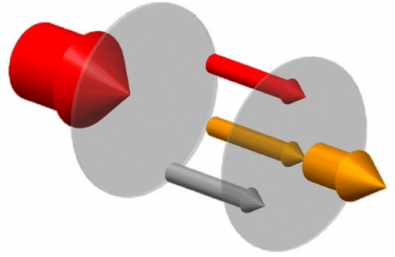
Figure 9. Schematic diagram illustrating the principle of the coupled solution method of cascade lasing for forward propagation.